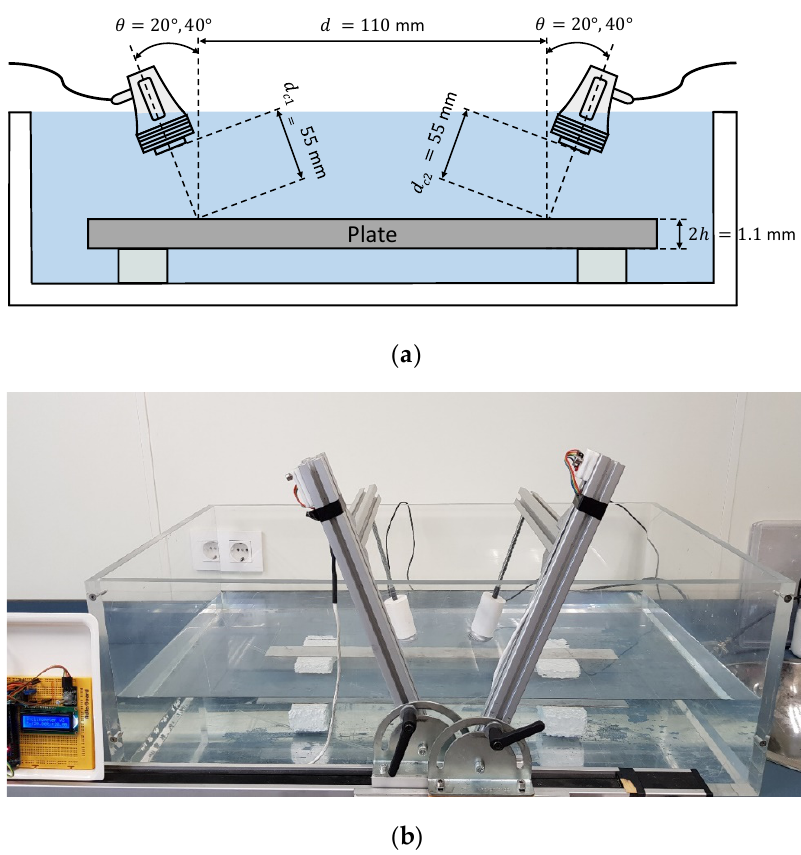
Figure 8. Immersion setup to measure the stainless-steel plate: ( a ) Schematic; ( b ) Photograph. The chosen angles for the water arrangement were 20° and 40° (see Figure 9). It was expected to excite S 0 mode with 20° and A 0 mode with 40°.